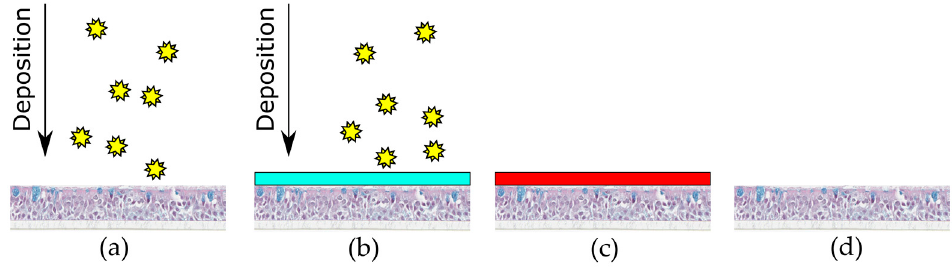
Figure 3. Experimental design for pollen deposition on MucilAir™. ( a ) pollen (symbolized by stars) deposited via VPC to MucilAir™ ( n = 6); ( b ) pollen deposited via VPC and protected by Bepanthen ® Eye and Nose Ointment (light blue bar) to MucilAir™ ( n = 6) ; ( c ) positive controls LPS stimulation on MucilAir™ (n = 3); and, ( d ) untreated negative control MucilAir™ in VPC ( n = 3).